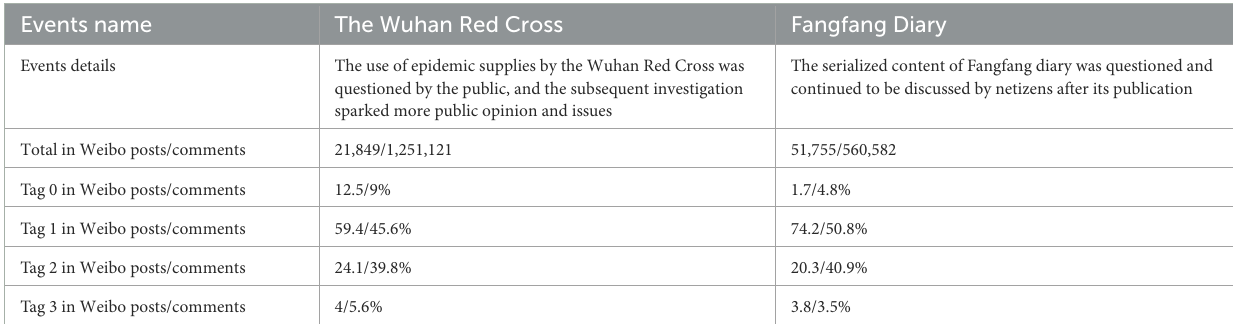
TABLE 1 Details of the two events and their proportions of different